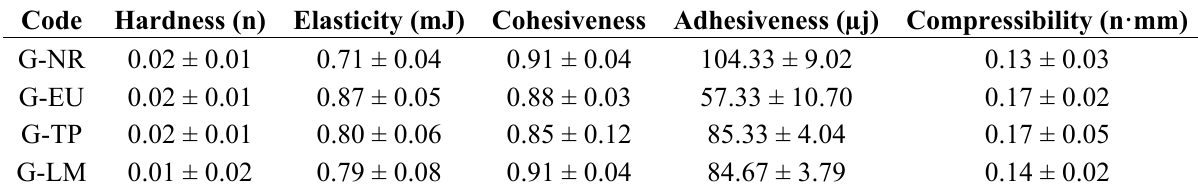
Table 2. The mechanical properties of gel formulations (G-NR, G-EU, G-TP, G-LM) used to formulate transdermal films ( n = 6).